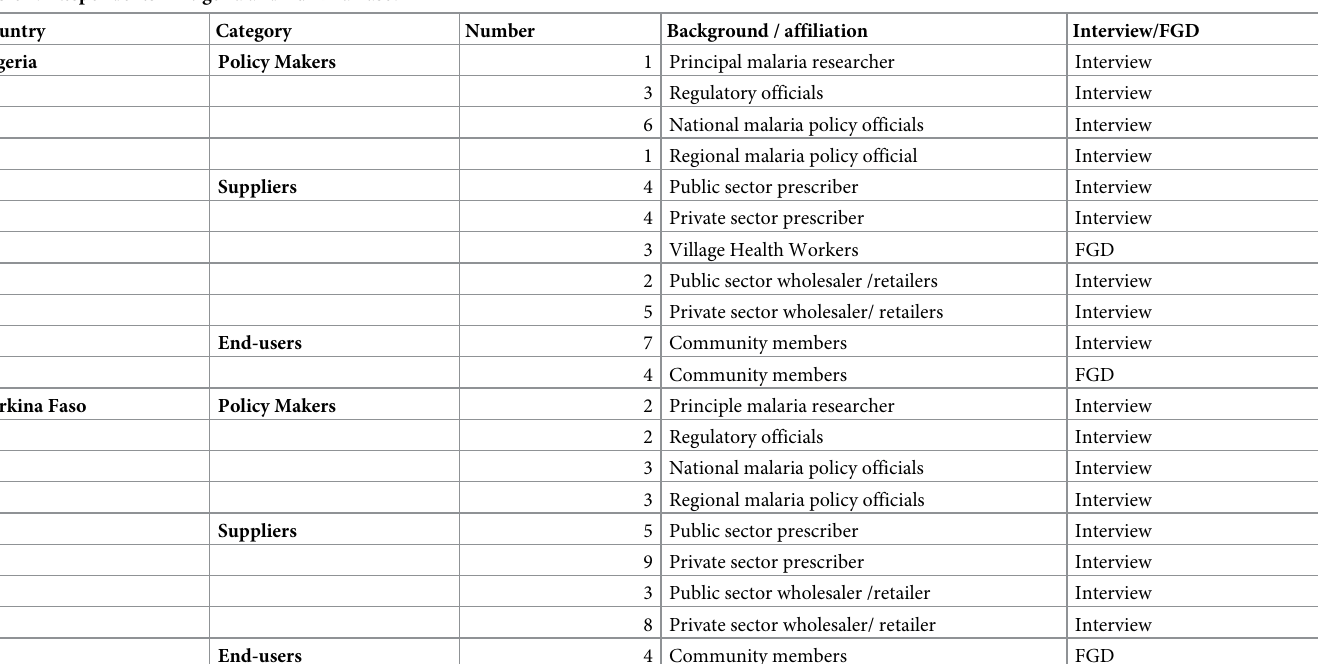
Table 2. Respondents in Nigeria and Burkina